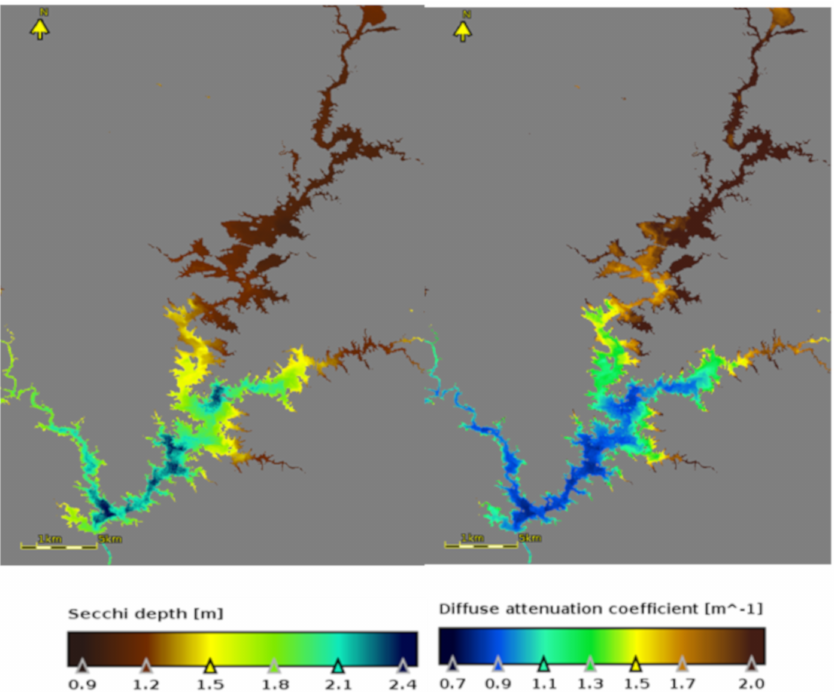
Figure 7. Secchi depth (left) and di ff use attenuation coe ffi cient (right) maps for the Alqueva reservoir on 22 September